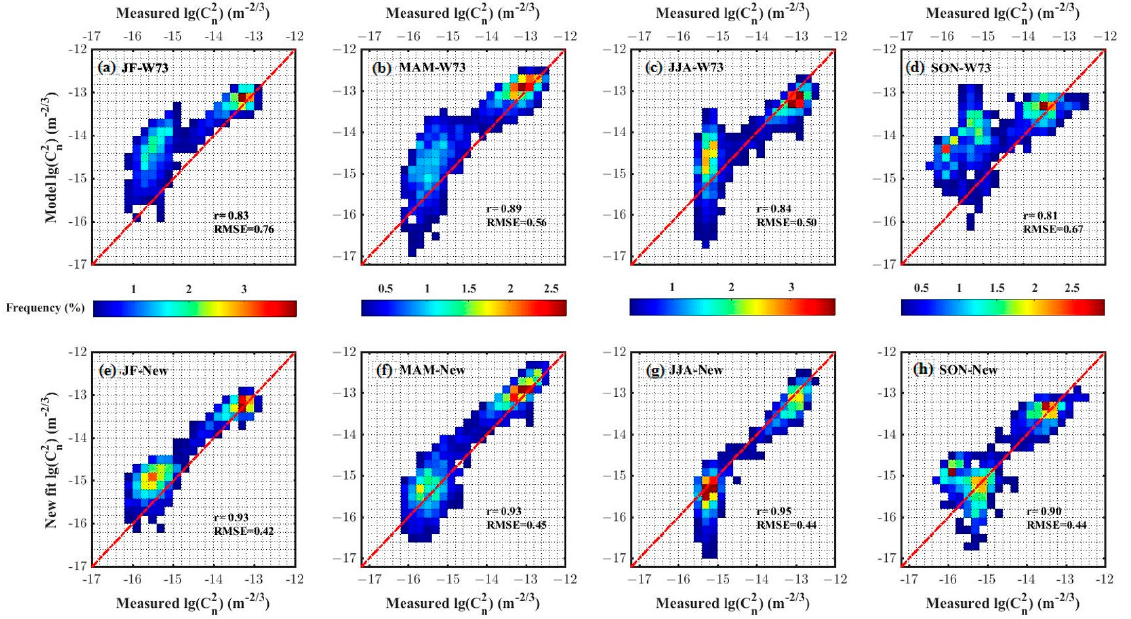
(cid:0) (cid:1) C 2 n of previous models and the new function ( 𝐶 𝑛2 ) of previous models and the new func- 10 (cid:0) (cid:1) 10 C 2 n estimated by the W73 model; ( e – h ) log ( 𝐶 𝑛2 ) estimated by the W73 model; ( e – h ) 𝑙𝑜𝑔 10 10